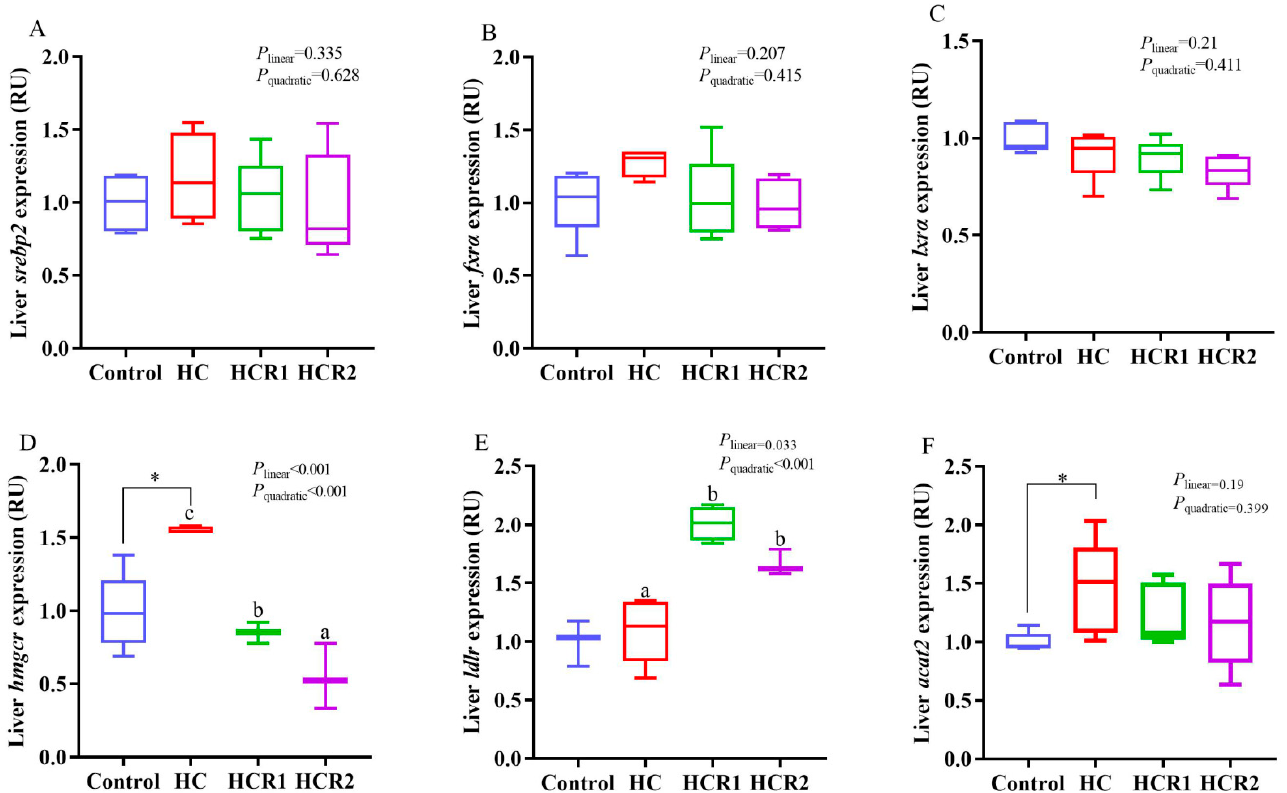
Figure 5. Hepatic transcriptions of the genes involved in cholesterol metabolism. The mRNA levels of sterol regulatory element-binding protein 2 ( srebp2 ) ( A ), farnesoid X receptor α ( fxr α ) ( B ), liver X receptor α ( lxr α ) ( C ), 3-hydroxy-3-methyl-glutaryl coenzyme A reductase ( hmgcr ) ( D ), low-density lipoproteins receptor ( ldlr ) ( E ), acyl coenzyme A: cholesterol acyltransferase 2 ( acat2 ) ( F ) were evaluated using real-time RT-PCR. Data are referred to the values (relative units, RU) obtained in fish fed the control diet. Each data point represents the mean of four replicates (4 individuals per replicate). * Means p < 0.05, compared between the control and the HC group. abc Compared among the HC, HCR1, and HCR2 groups. Bars assigned with different superscripts are significantly different ( p < 0.05). The first and third quartiles are represented by the top and bottom of the box, while the minimum and maximum values are represented by the whiskers. Control, diet with 32% nitrogen-free extract; HC, diet with 45% nitrogen-free extract; HCR1, diet with 45% nitrogen-free extract and 0.04% resveratrol; HCR2, diet with 45% nitrogen-free extract and 0.08% resveratrol.